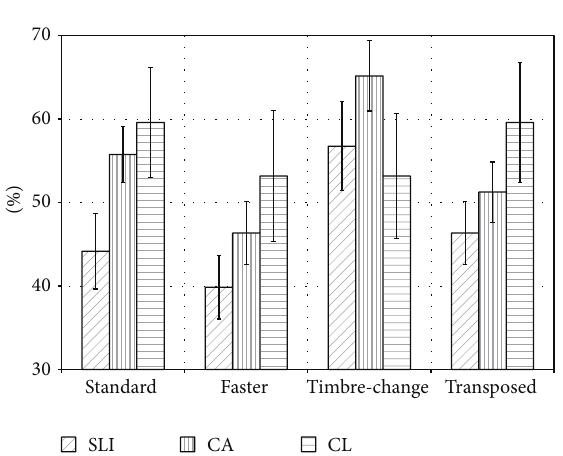
Figure 4: Mean percentage of correct responses (and standard error of mean) for the four subtests of the melody recognition